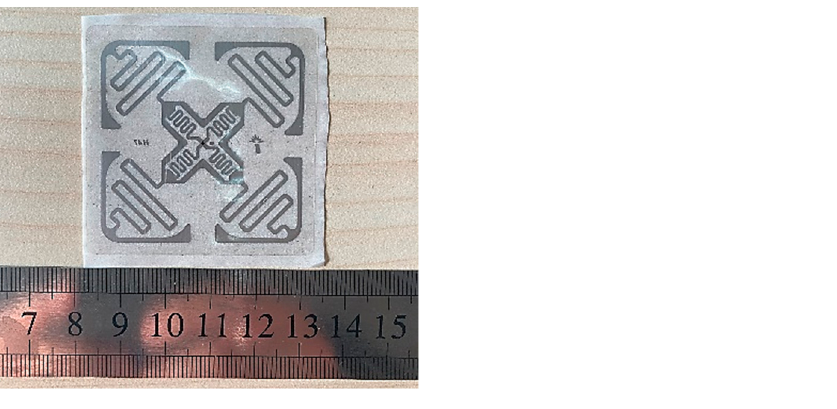
Figure 4. UHF RFID Inlay Tag (JT-IH47); the length and width of the label are both 5.12 cm.